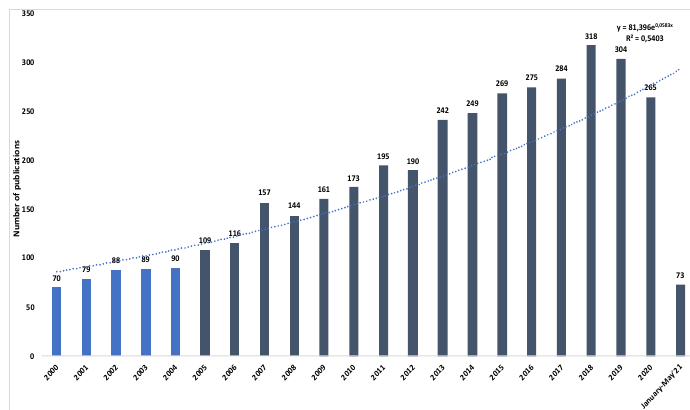
Figure 1. Number of publications per